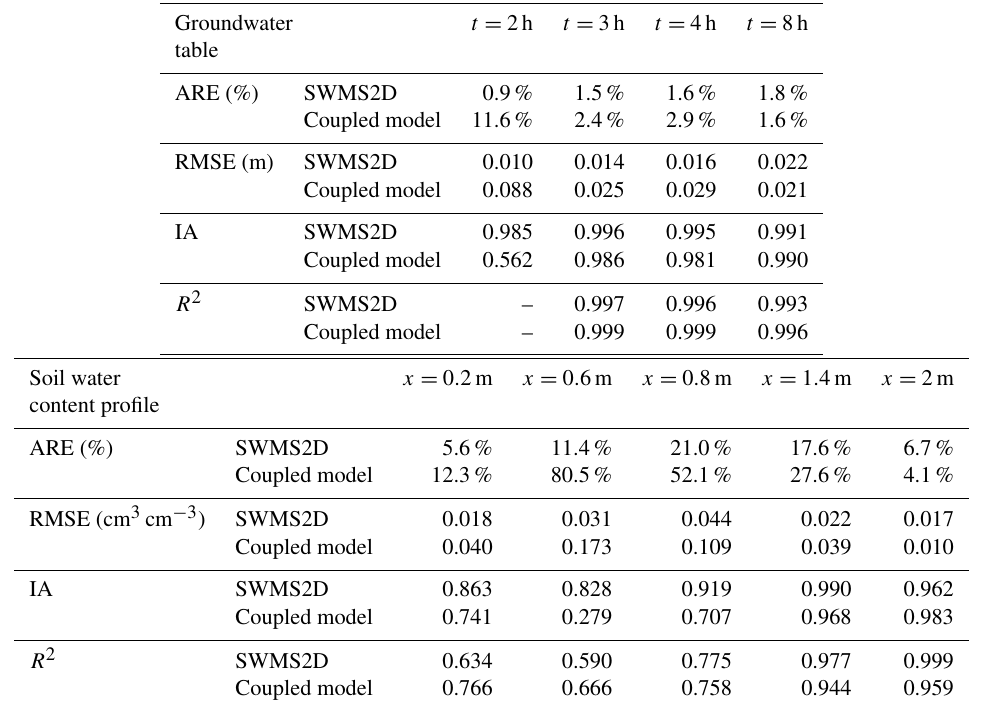
Table 3. The statistical index values of SWMS2D and the coupled model of case 2. Groundwater ARE